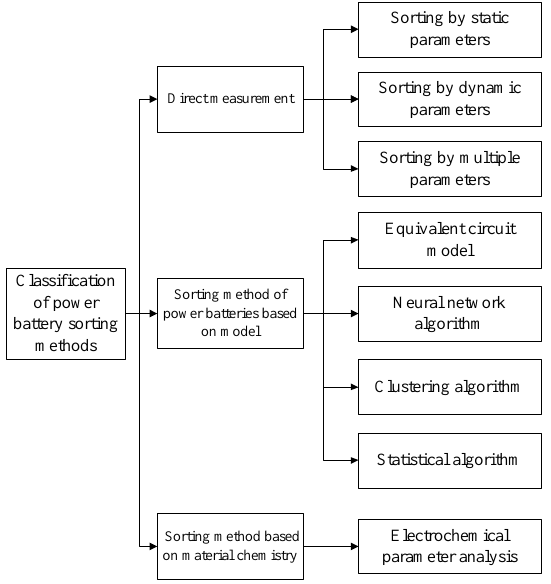
Figure 1. Summary of current power battery sorting methods.